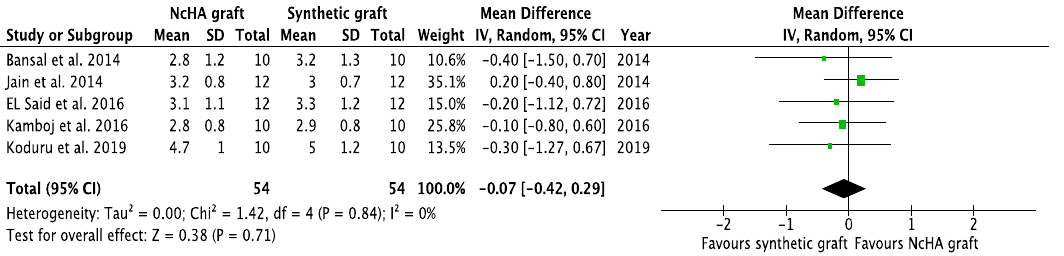
Figure 6. Forest plots demonstrating the comparison of NcHA graft versus synthetic graft (CAL gain). NcHA: nanohydroxyapatite; IV: inverse variance; SD: standard deviation; Total: number of patients; 95% CI: confidence interval.